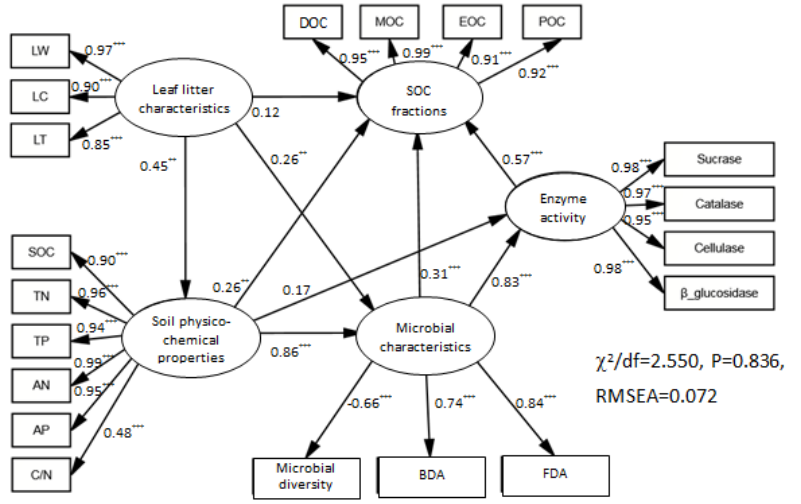
Figure 3. The structural equation model (SEM) describes the multivariate effects of environmental fac- tors on SOC fractions. BDA, Bacterial decomposer abundance; FDA, fungal decomposer abundance. ** Significant correlation at 0.05 level; *** Significant correlation at 0.01 level.